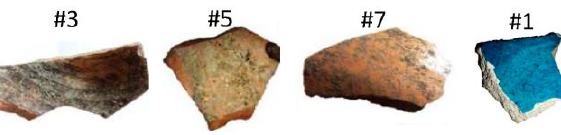
Table 1. Investigated samples, typology and related